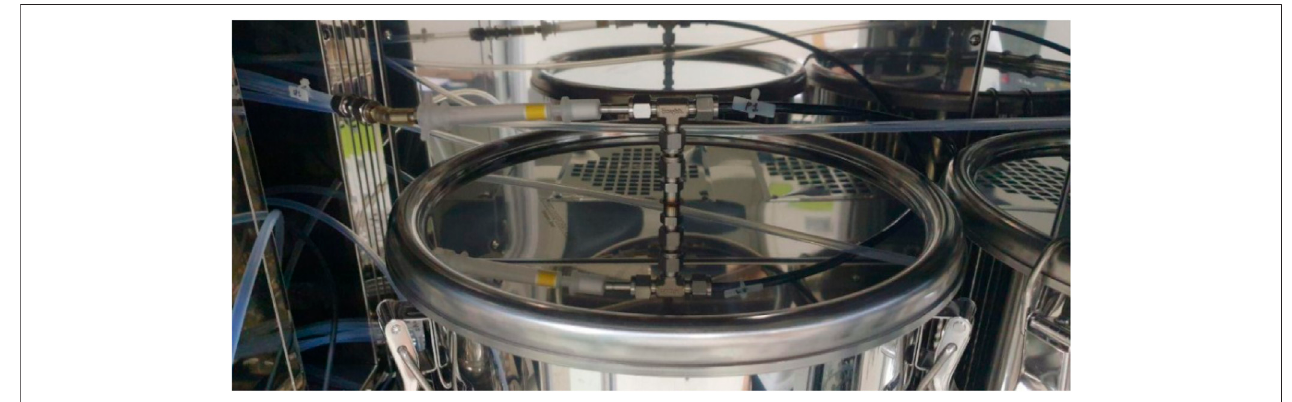
FIGURE 3 | Small chamber